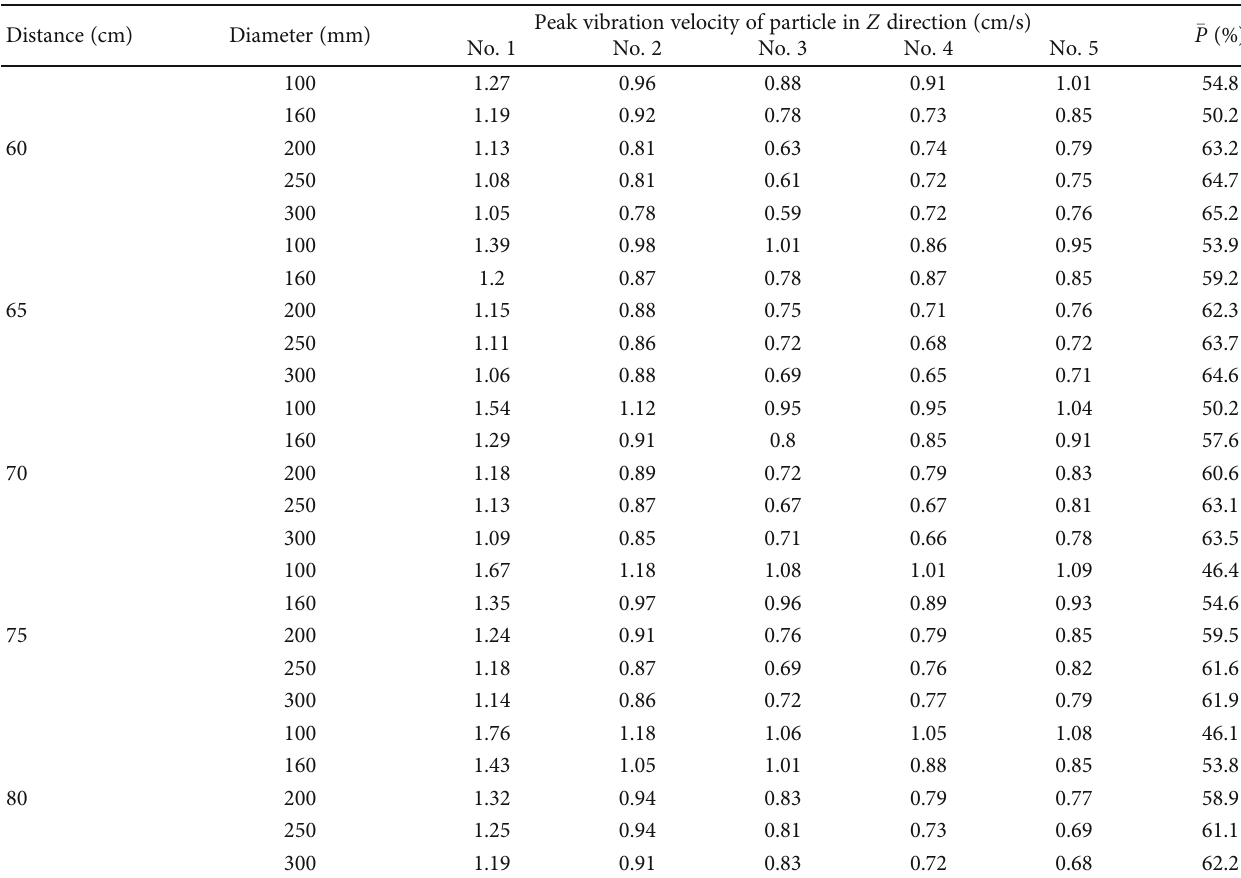
Table 13: Peak values and average reduction degree of the vibration velocity in the Z direction.